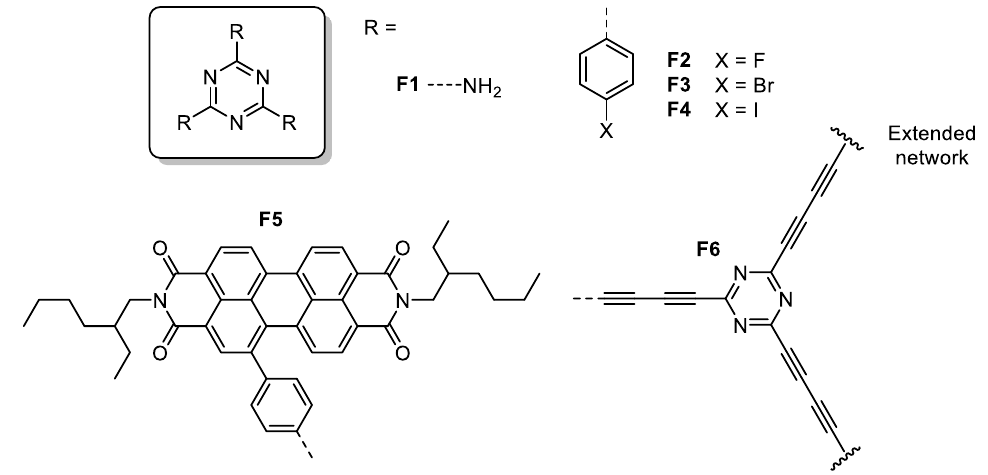
Figure 13. Chemical structures of triazine derivatives employed in surface passivation of PSCs. Table 6. Photovoltaic parameters of PSCs using triazine derivatives for surface